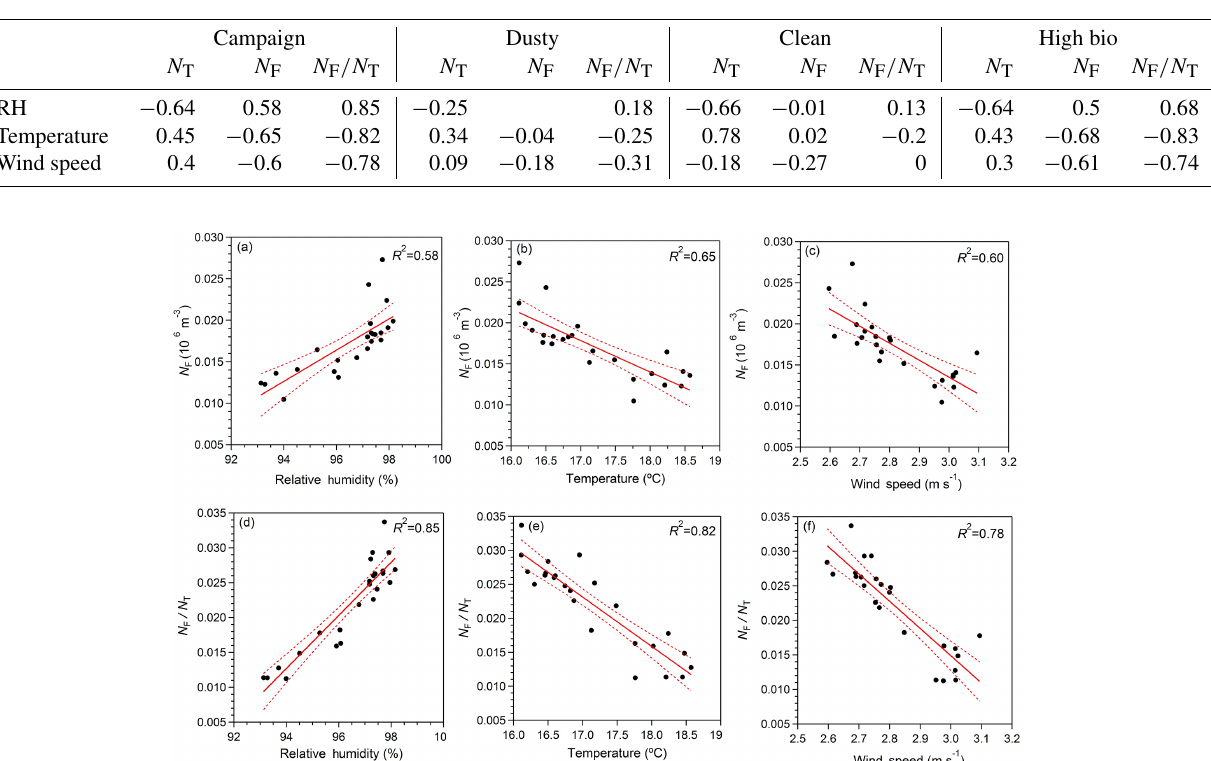
Table 5. R 2 values for the correlation between meteorological parameters (RH, temperature and wind speed) and N T , N F and N F /N T during the entire campaign and each focus period.